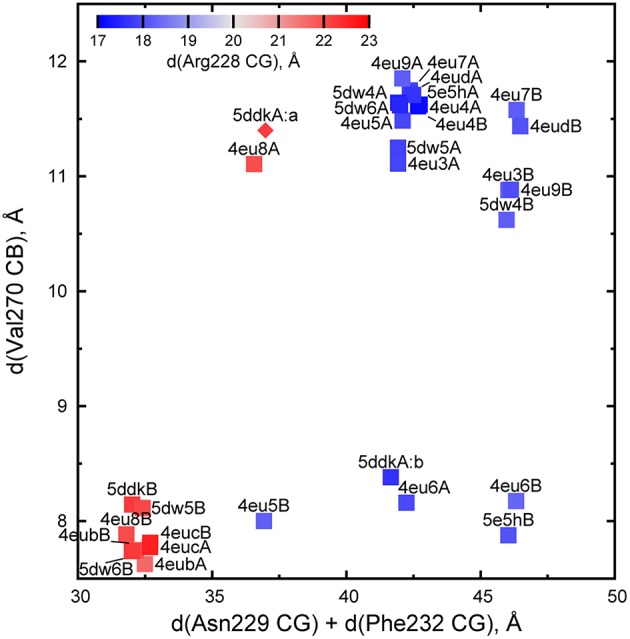
Parametrization of AarC(H6) active site conformations. Each point represents one subunit of AarC (PDB entry 4eud) or AarCH6 and its mutant forms (remaining points). The values are derived from distances (d) between Gly388 N, a fixed reference point within the active site, and the indicated atom(s) in a wild-type or mutant subunit. All proteins crystallized in an orthorhombic lattice apart from 4eu4, which is in a hexagonal lattice (Mullins and Kappock, 2012). Note that the two hexagonal subunits adopt almost identical open conformations. The open conformations of subunit B in orthorhombic crystals form a sub-cluster (upper right) due to crystal contacts described in the text. One Val270 CB position was estimated for one minor conformer (5ddkA:a, diamond symbol) using real-space refinement.